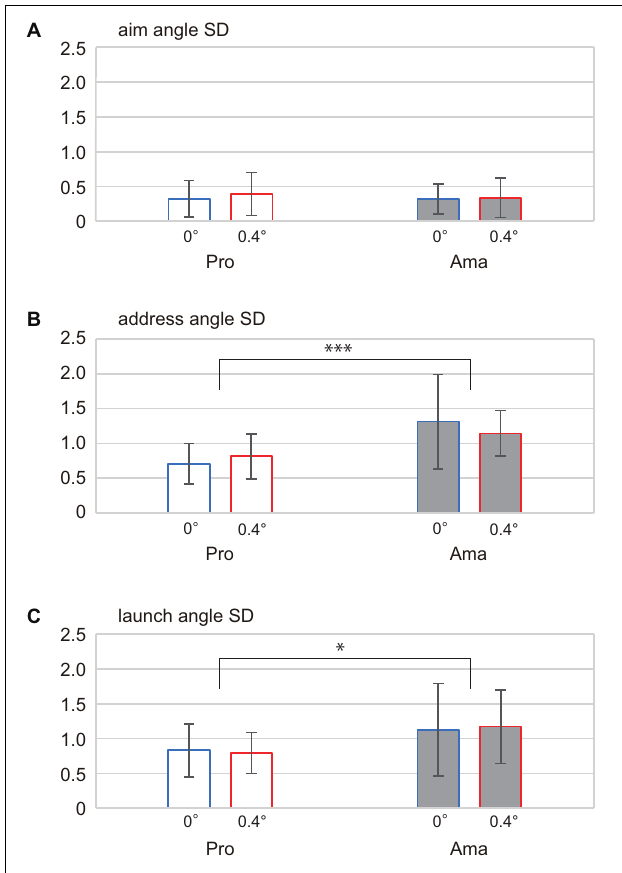
FIGURE 5 | Average angle SDs for each phase in the 0- and 0.4-degree conditions. These values showed the intraindividual variability of face angles for each phase and were averaged for each group. * p < 0.05 and *** p < 0.001.